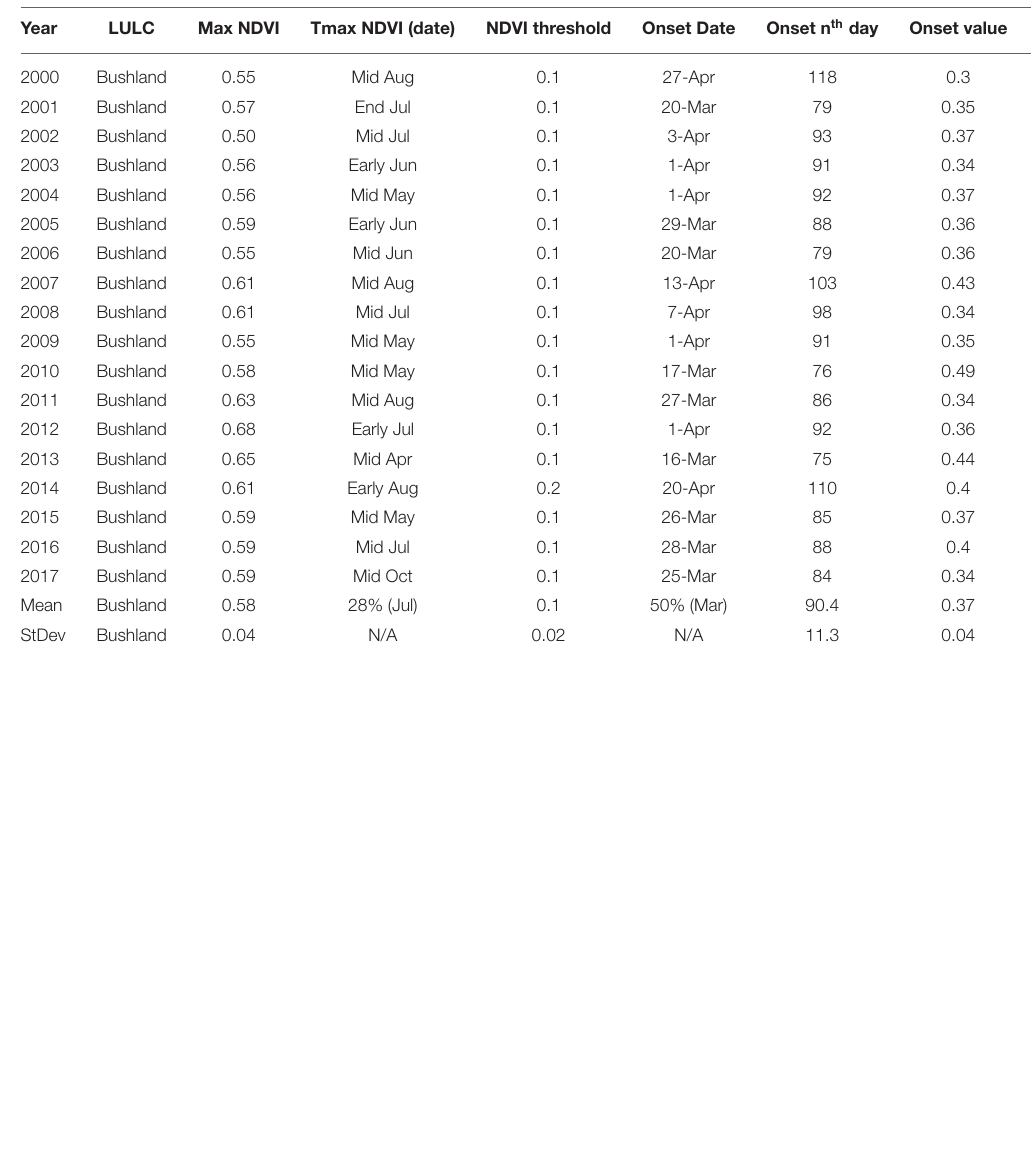
TABLE 2 | Bushland phenological metrics for the Karamoja region in Uganda for the period